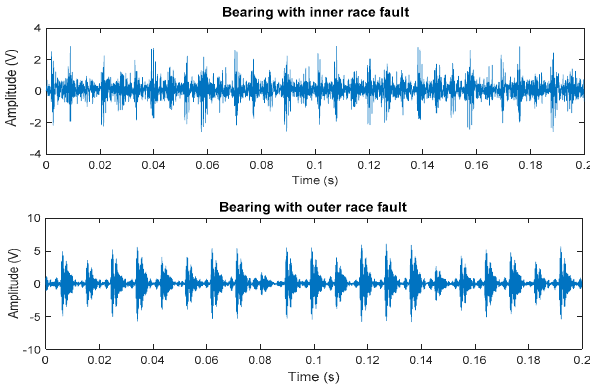
Figure 20. Experimental data of inner and outer raceway fault.